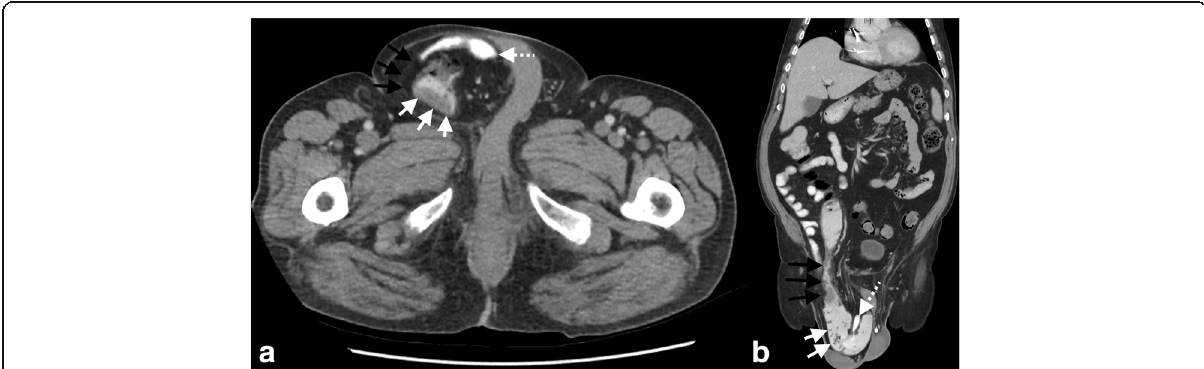
Fig. 2 Computed tomography. a Axial view demonstrating right-sided inguinoscrotal hernia (black arrows) containing large bowel with thickening of the wall representing the ascending colon cancer (white arrows) and herniated terminal ileum (dashed white arrow). b Coronal view demonstrating the right- sided inguinoscrotal hernia (black arrows) with large bowel (white arrows) and terminal ileum (dashed white arrow) herniating through the inguinal canal